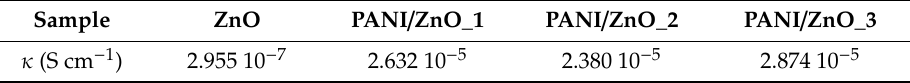
Table 2. Conductivity of pure ZnO and prepared composite photocatalysts (PANI/ZnO). Sample